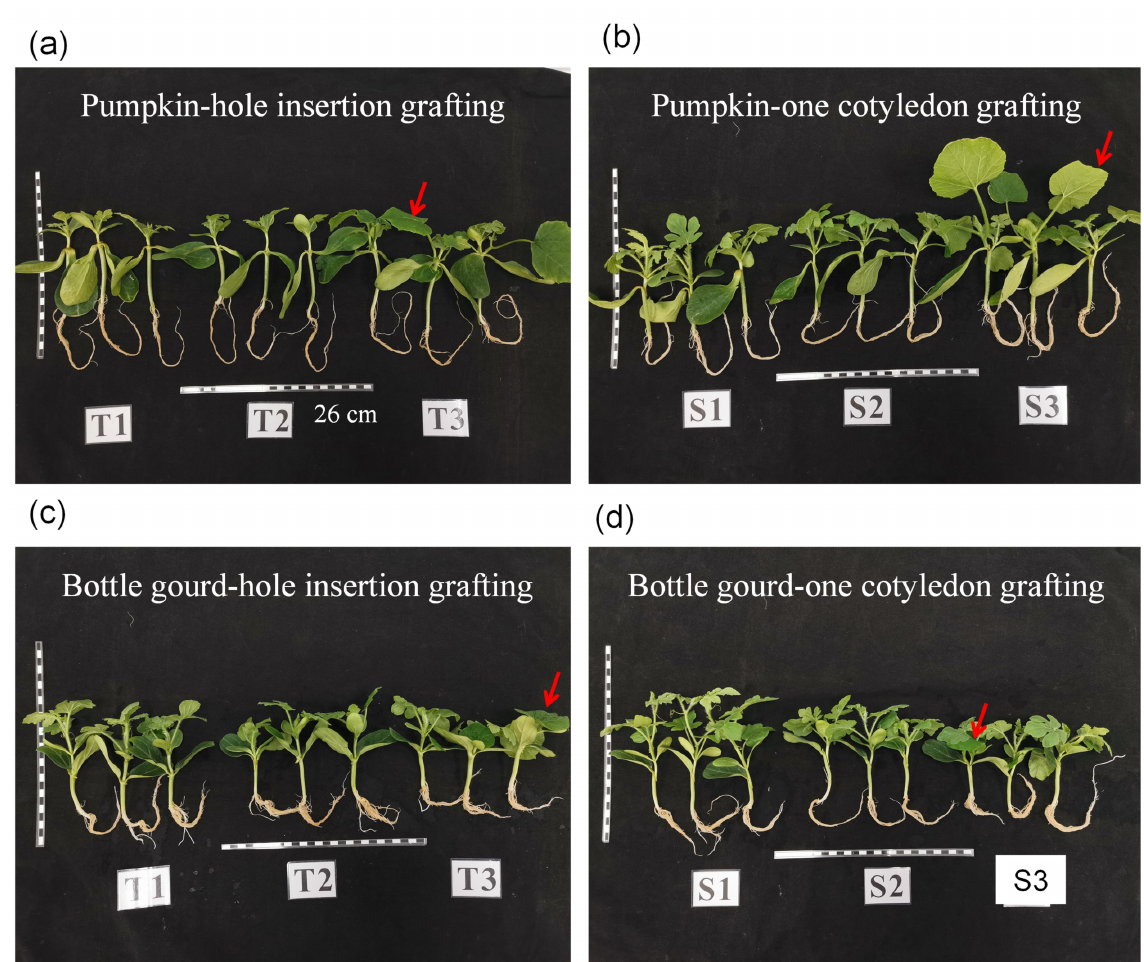
Figure 4. Watermelon growth pictures at day 14 after grafting. T1 and S1, new “hole insertion grafting” ( a , c ) and “one cotyledon grafting” ( b , d ), respectively, without the regrown rootstock removal; T2 and S2, traditional “hole insertion grafting” ( a , c ) and “one cotyledon grafting” ( b , d ), respectively, with manual regrown rootstock removal 3 times; T3 and S3, traditional “hole insertion grafting” ( a , c ) and “one cotyledon grafting” ( b , d ), respectively, without the regrown rootstock removal. Red arrow indicates rootstock